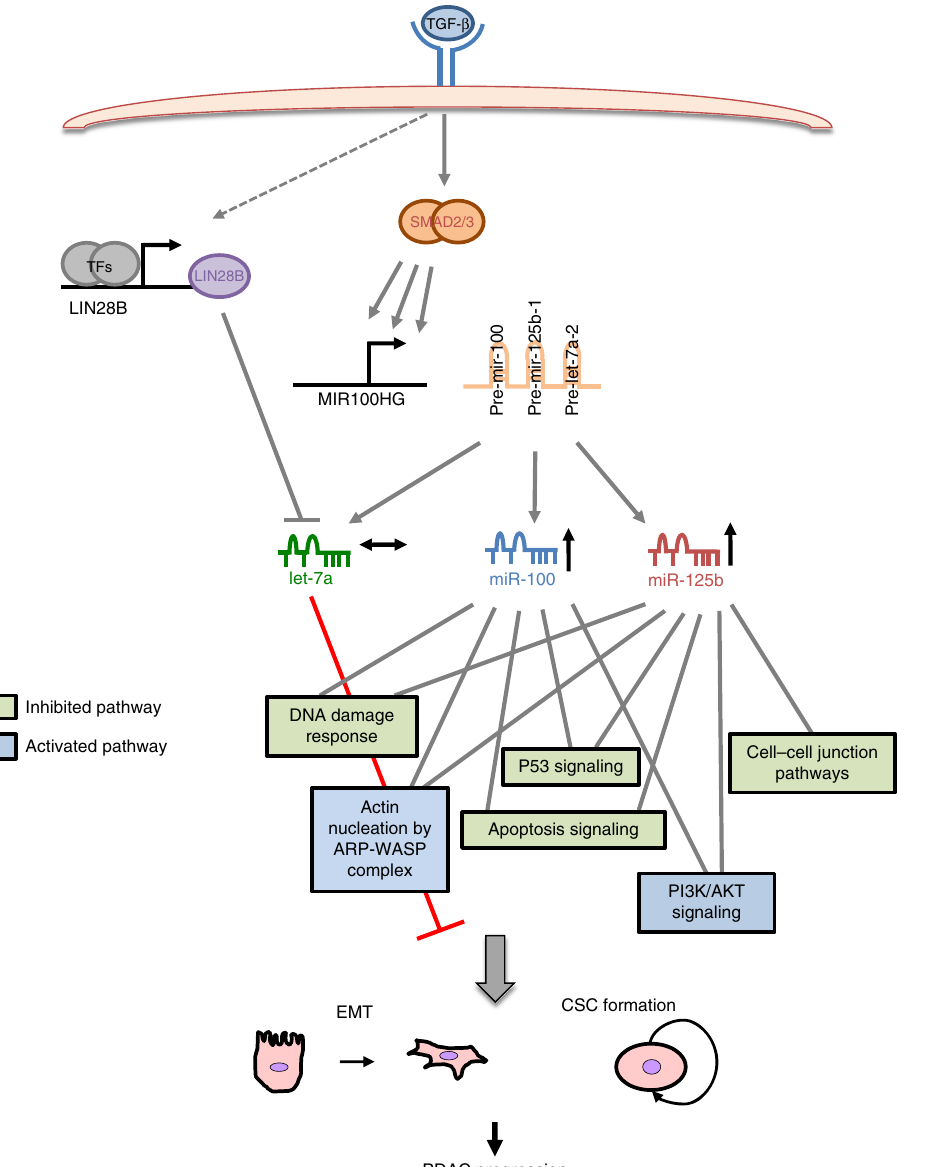
Fig. 8 Proposed mechanism of action of TGF- β regulated miR-100 and miR-125b in